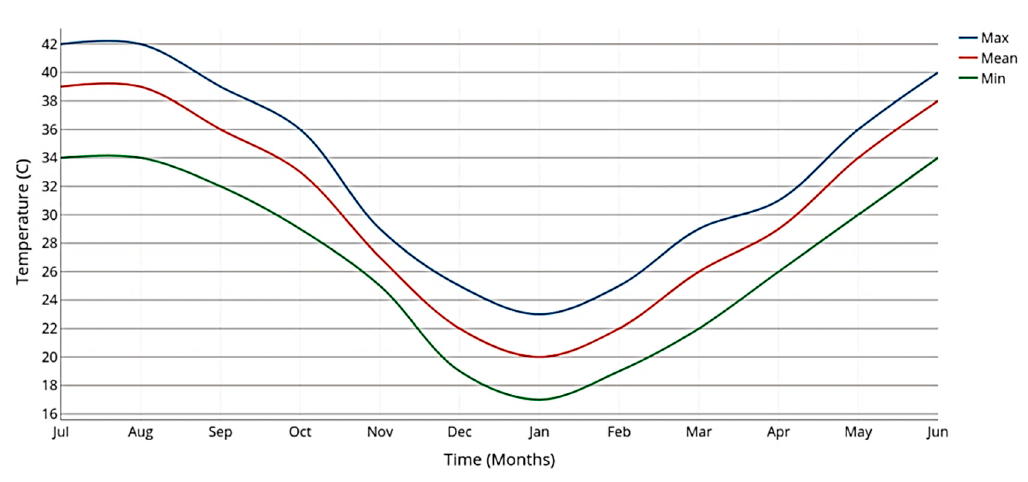
Figure 4. Daily electricity load profiles of Houses 1, 2, 6, 7 & 8 (July 2017 and August 2018).